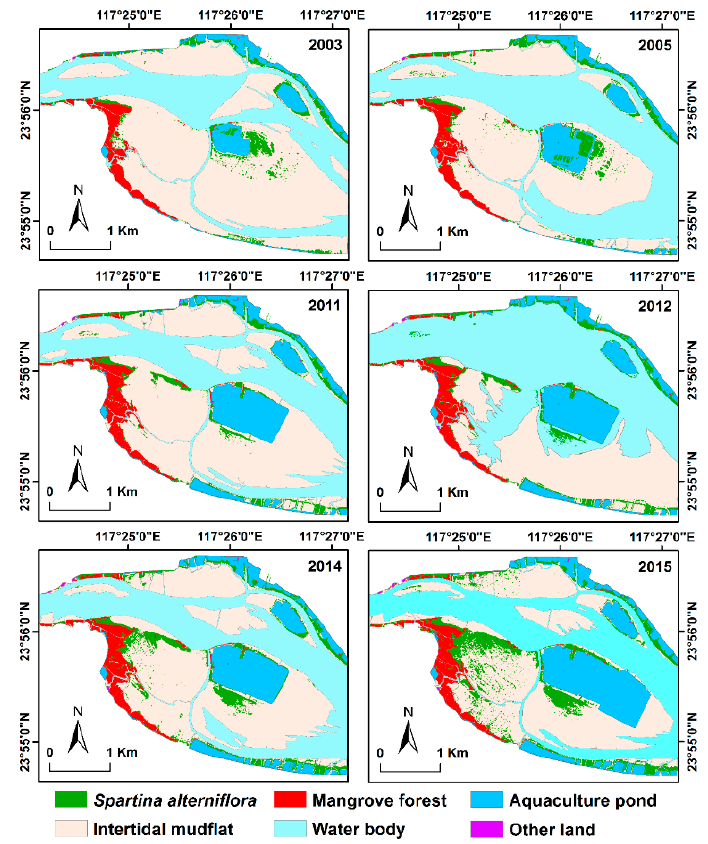
Figure 3. Land cover maps of the Zhangjiang Estuary from 2003 to 2015.